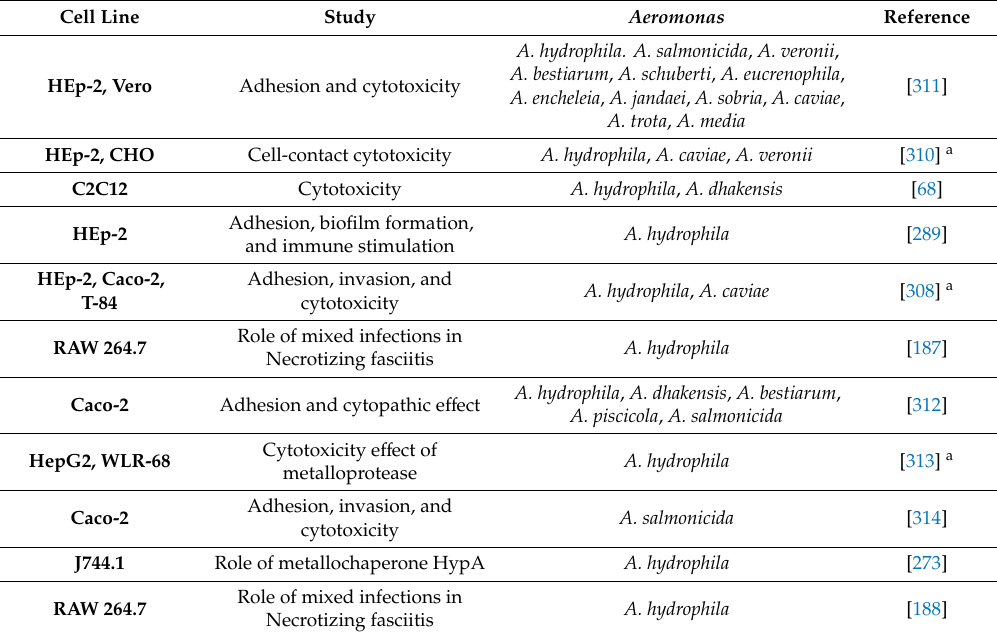
Table 3. Studies (2009–2019) that investigate the virulence and pathogenicity of Aeromonas spp. using di ff erent cell lines (adapted from